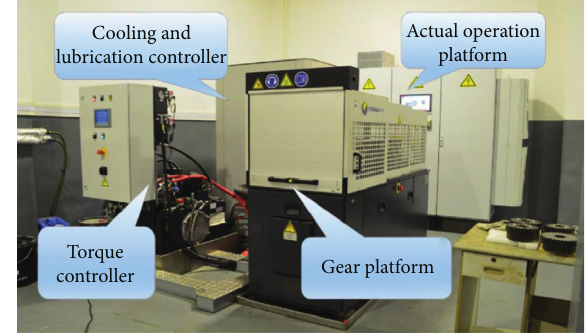
Figure 13: Gearbox testing Table 7: Details of gearbox datasets [26].